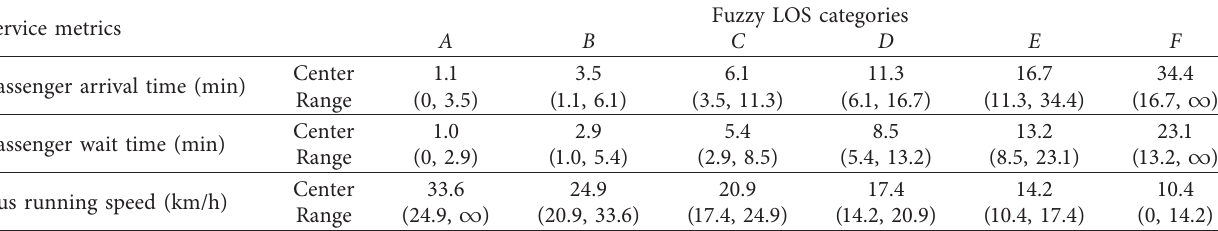
Table 2: BRT fuzzy LOS criteria for the calm passenger group (ranges and centers of service metrics for fuzzy LOS categories). Service metrics